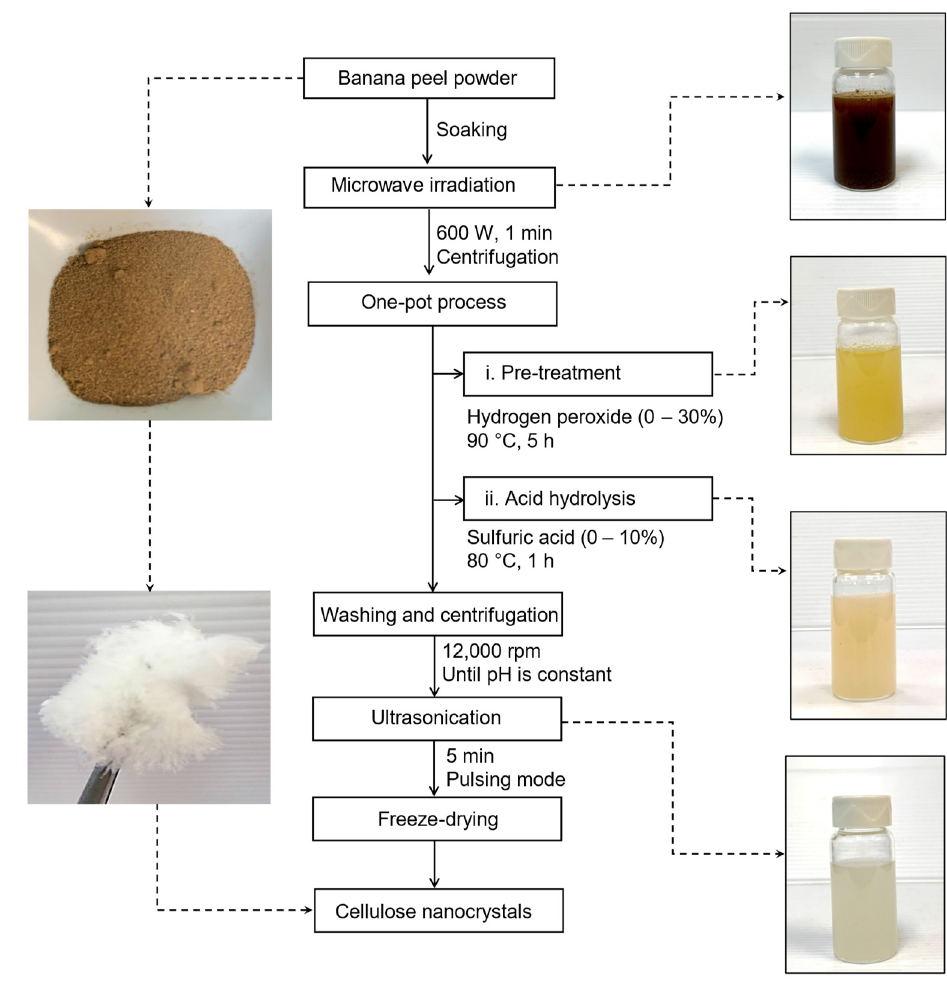
Figure 1. Step-by-step procedures for isolation of CNCs from banana Figure 1. Step ‐ by ‐ step procedures for isolation of CNCs from banana peel.